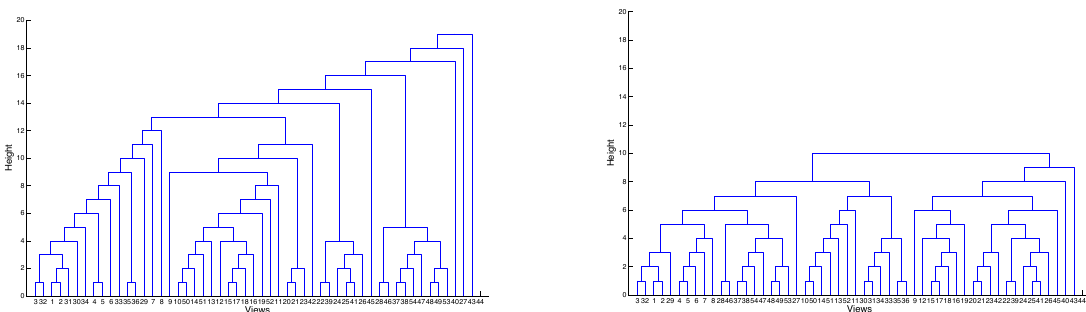
Figure 3: Two dendrograms produced on a 52-views set. The left one was produced using the standard simple linkage rule, the right using the modified rule, with ￿ = 5